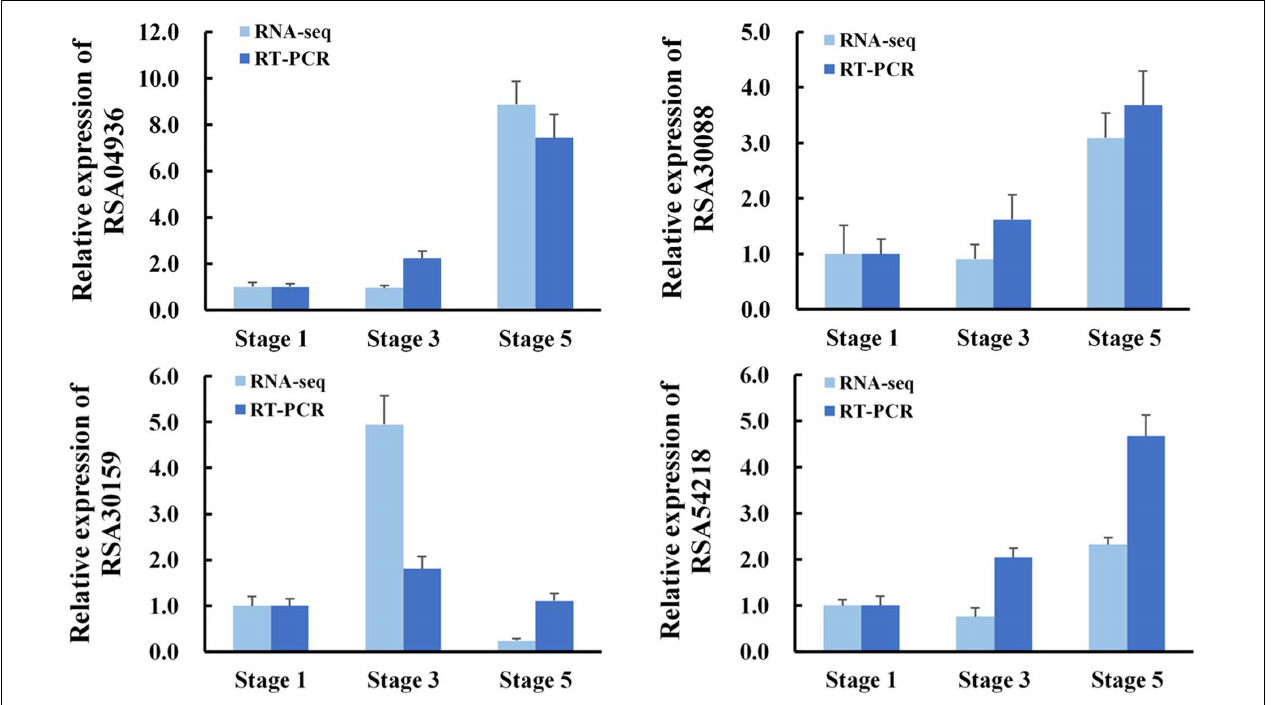
FIGURE 2 | Validation of RNA-Seq results by quantitative RT-PCR (qRT-PCR). RNA was extracted from petal AZ at the indicated flower opening stage. RhActin5 was used as an internal control. The results were the means of three biological replicates ± SD. RSA04936, GDSL esterase/lipase ; RSA30088, Receptor-like protein kinase ; RSA30159, Lachrymatory-factor synthase ; RSA54218, Zinc transporter .